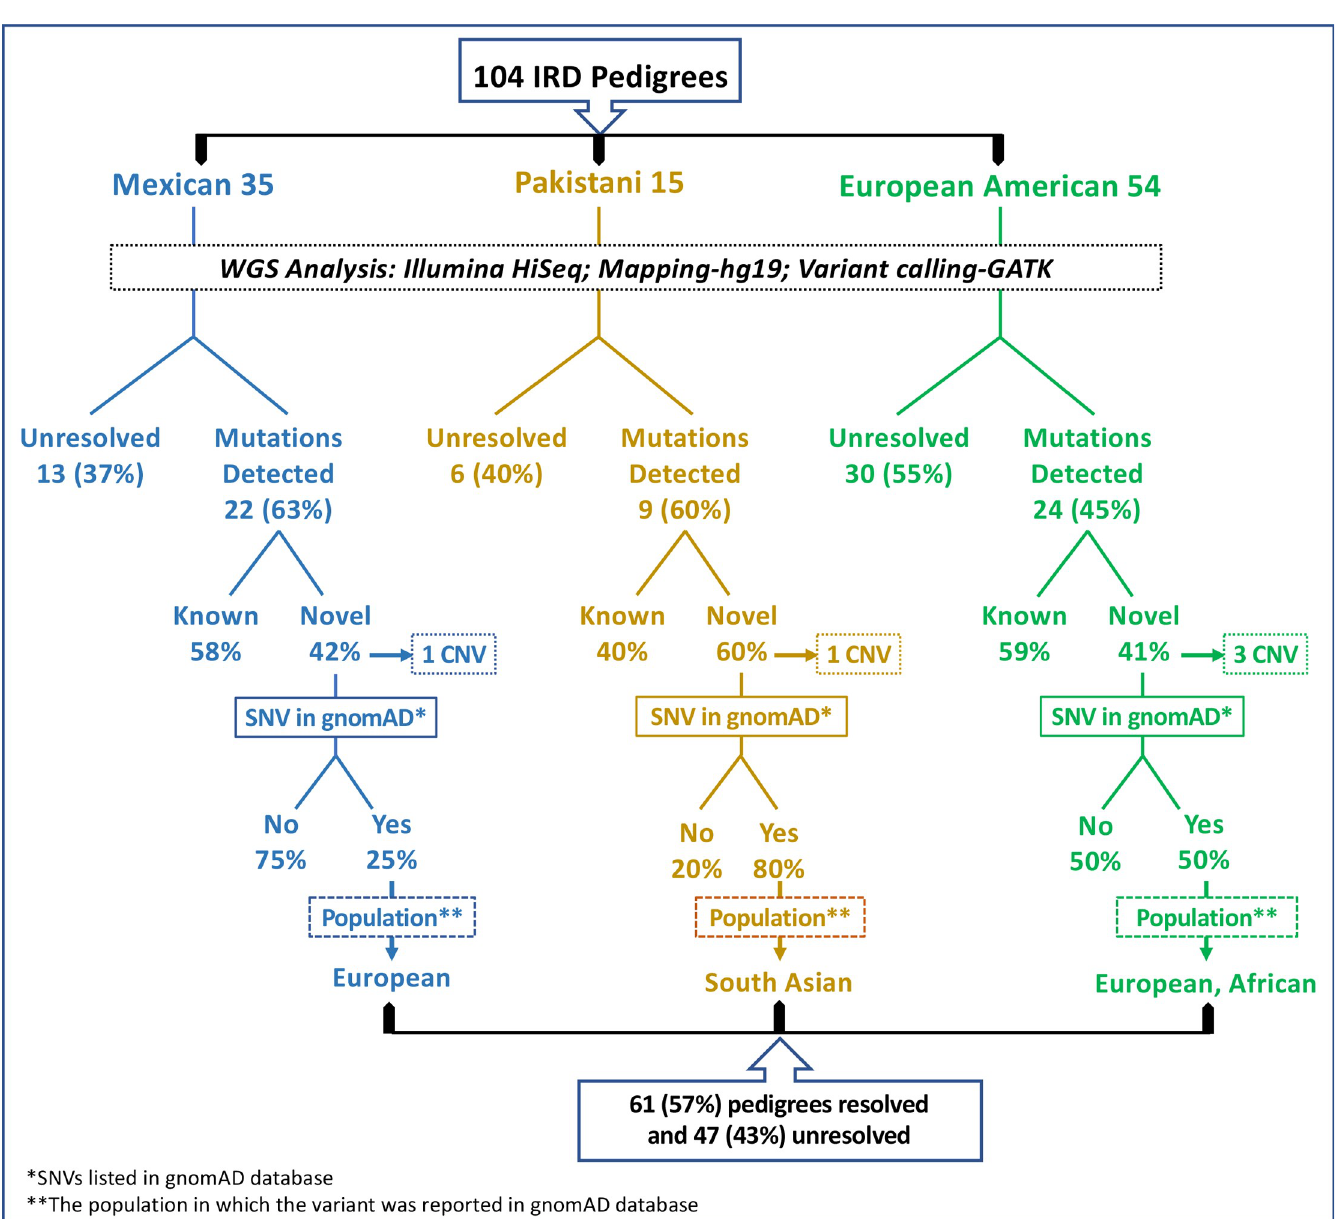
Fig 6. Summary of findings and population distribution of novel mutations detected in Mexican, Pakistani and European American pedigrees.